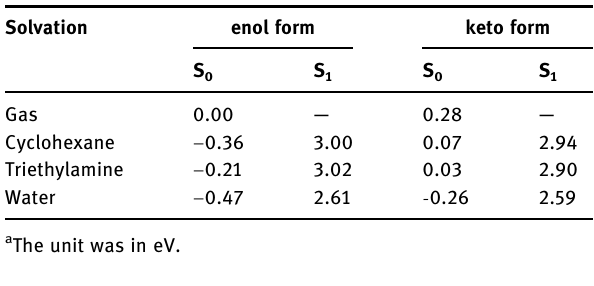
Table 2: The relative energy of enol form and keto form at the optimized geometry in the various solvations a